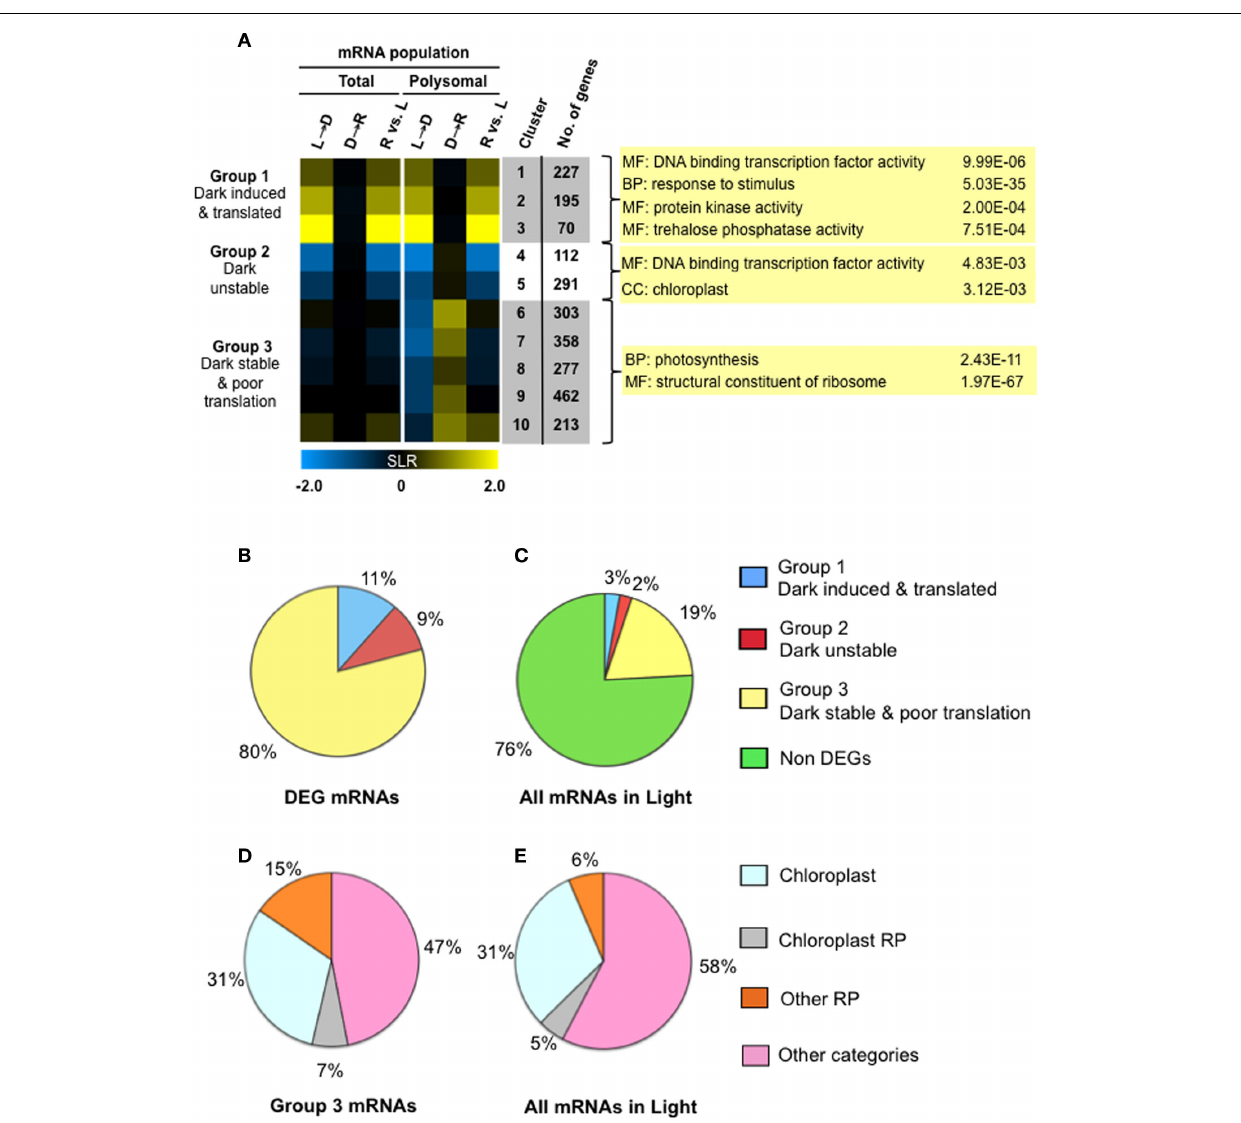
FIGURE 6 | Light availability alters both transcript accumulation and translational status as a mechanism of energy conservation. (A) Fuzzy k -mean clustering analysis performed on six mean signal log ratio (SLR) comparisons of total and immunopurified polysomal mRNA transcript abundance. Genes included in the analysis were those without all “absent” calls and significantly different in abundance (FDR < 0.05; n = 2508 probe pair sets).The comparisons and genes evaluated are the same as those represented in Figure 3 (Table S1A in Supplementary Material).The heatmap shows median SLR values for each of 10 clusters of mRNAs that displayed similar responses to light availability based on the total and polysomal mRNA populations; color indicates increase (yellow), decrease (blue) or no-change (black) in mRNA abundance. Columns indicate cluster ID, number of genes (No. genes). Selected gene